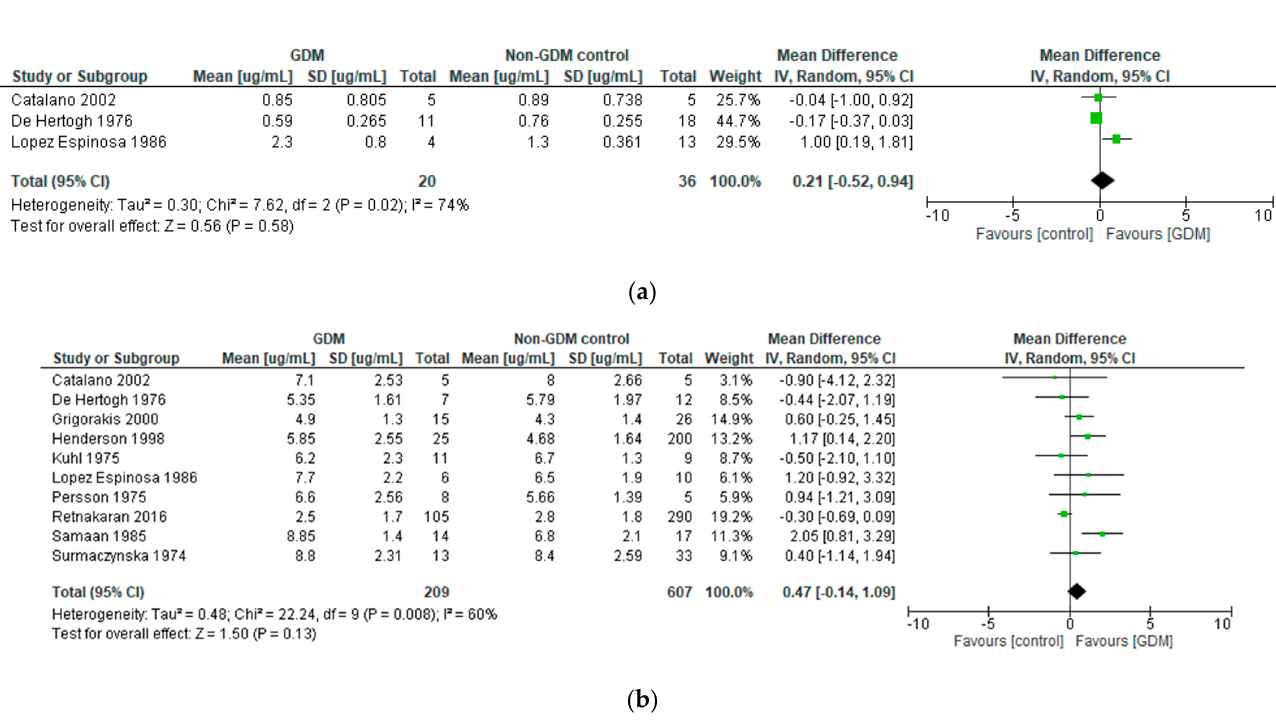
Figure A2. ( a ): Meta-analysis of hPL levels in GDM vs. non-diabetic control women in early pregnancy ( ≤ 24 weeks)—3 studies. ( b ): Meta-analysis of hPL levels in GDM vs. non-diabetic control women in late pregnancy (>24 weeks)—10 studies. Table A2. Studies examining hPL in pregnancies affected by gestational diabetes mellitus—17 studies.